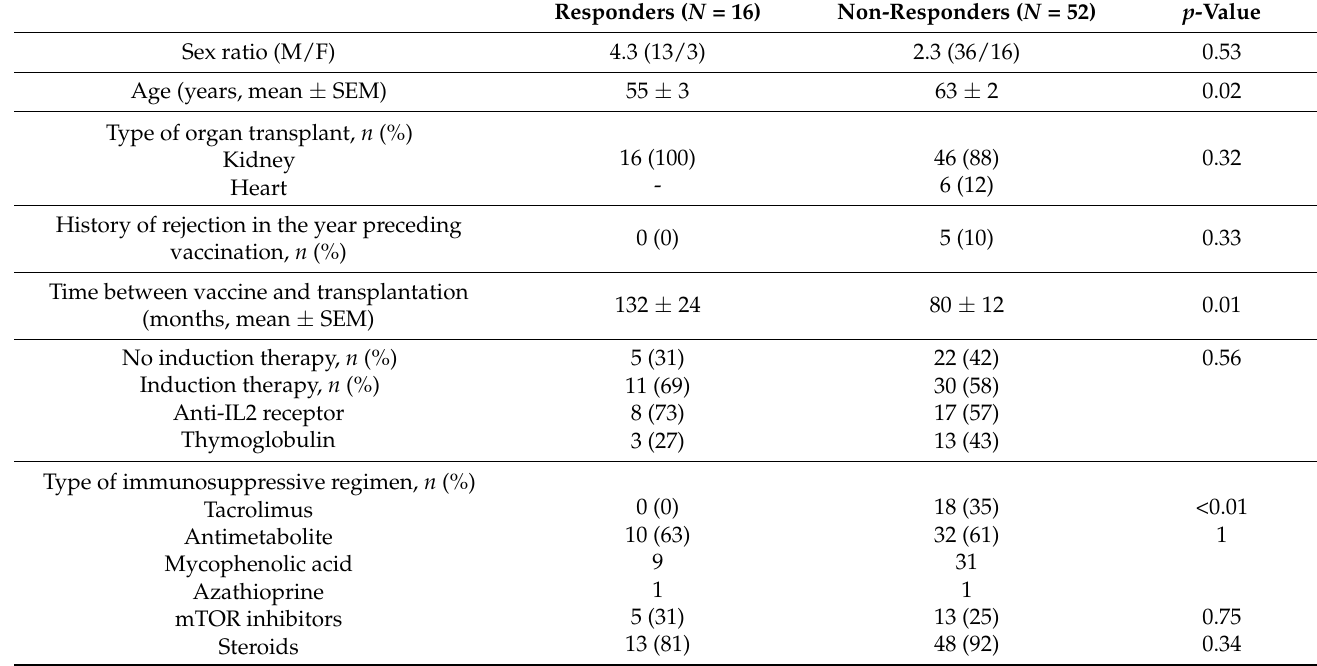
Clinical and biological characteristics of solid organ transplant recipients treated with